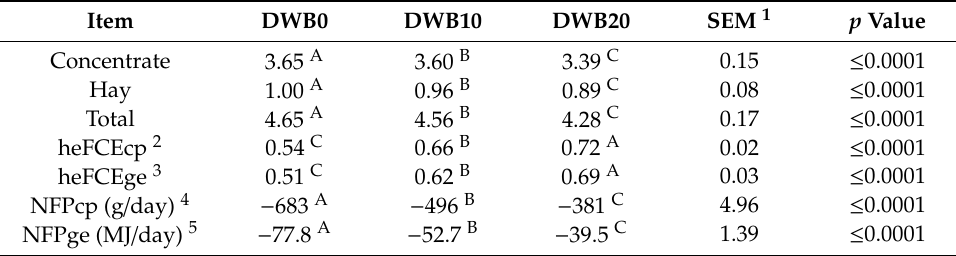
Table 9. Cost of the rations ( € / day per head) and feed conversion e ffi ciency indexes for human food production. Item DWB0 DWB10 DWB20 SEM 1 p Value Concentrate 3.65 A